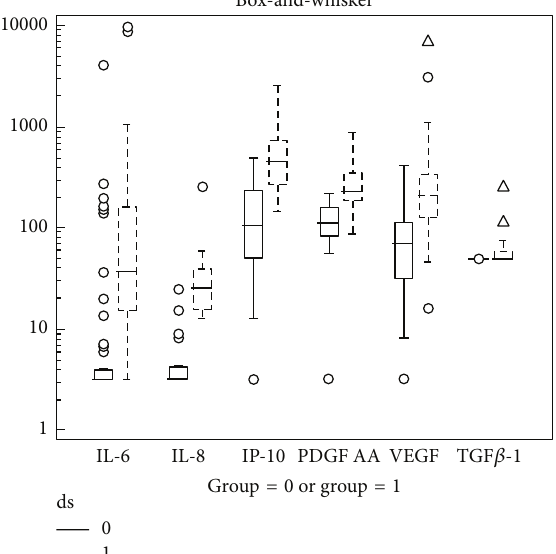
Figure 2: Levels of biomarkers for which significant differences between the levels in control group 0 and those in proliferative diabetic retinopathy group 1 were found. IL: interleukin; IP-10: 𝛾 - interferon inducible protein 10; PDGF AA: platelet-derived growth factor AA; VEGF: vascular endothelial growth factor; TGF 𝛽 -1: transforming growth factor beta